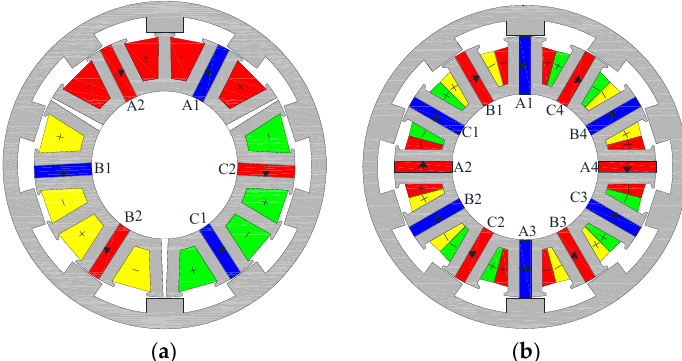
Figure 13. Cross-sectional views: ( a ) Cross-sectional view of MSOR-FSPM motor; ( b ) Cross-sectional view of COR-FSPM motor.